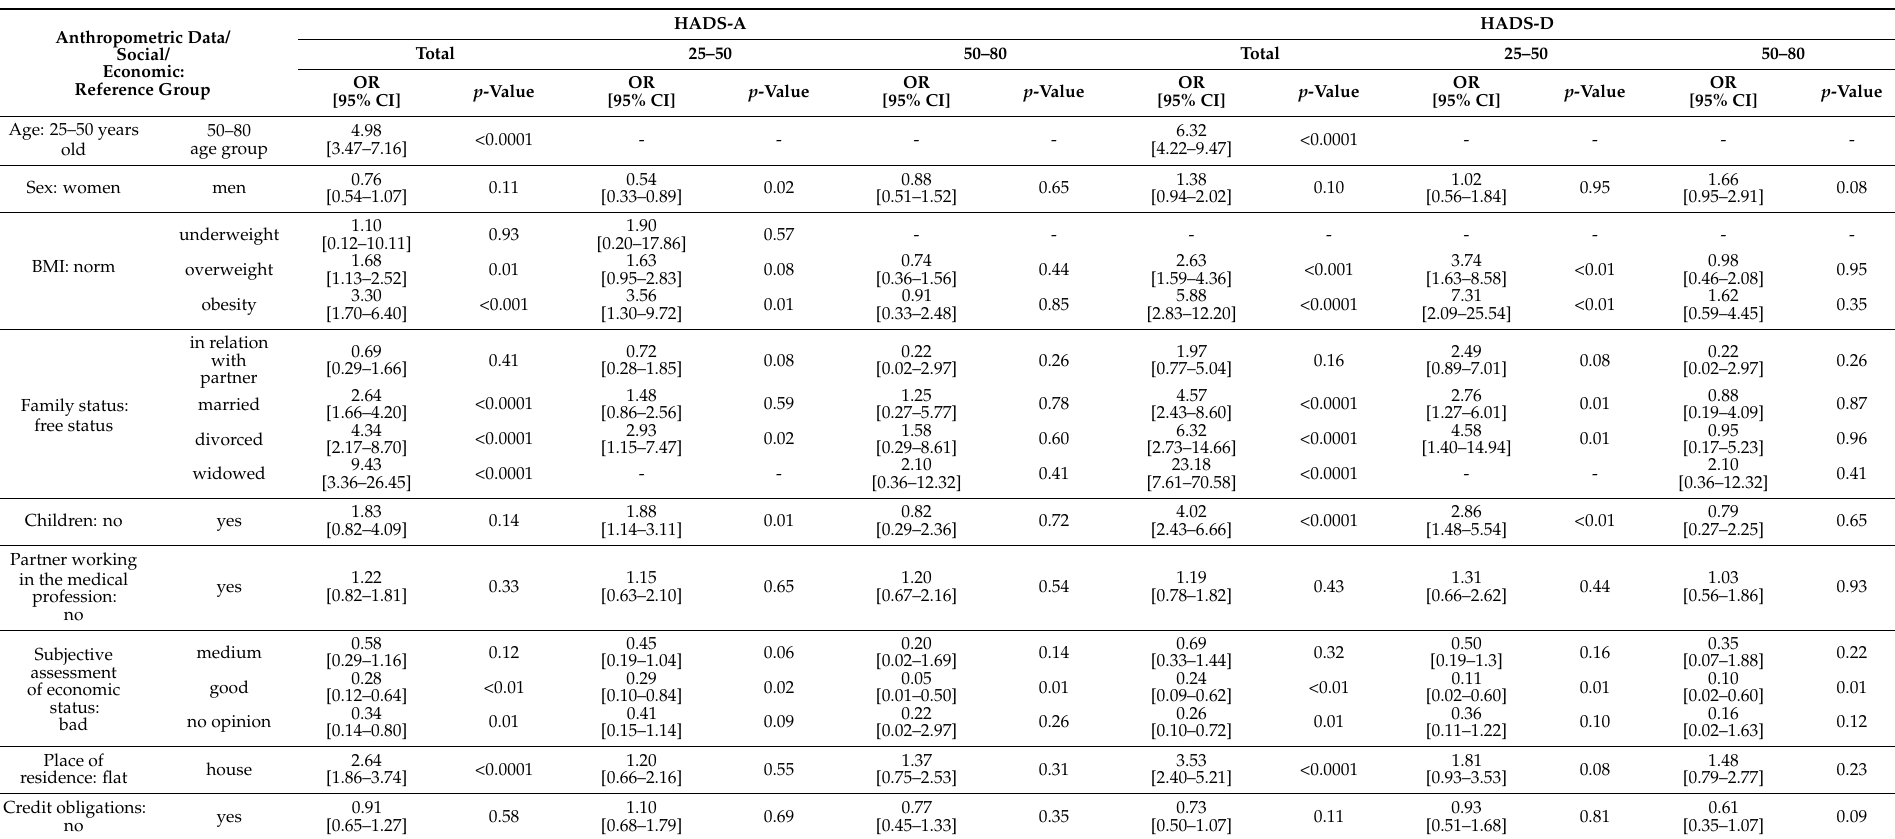
Table 2. Crude odds ratios (OR) with 95% confidence interval (CI) for the relationship between the occurrence of anxiety disorders (12 points or more on the HADS-A scale) and depression (12 points or more on the HADS-D scale) and anthropometric and socio-economic